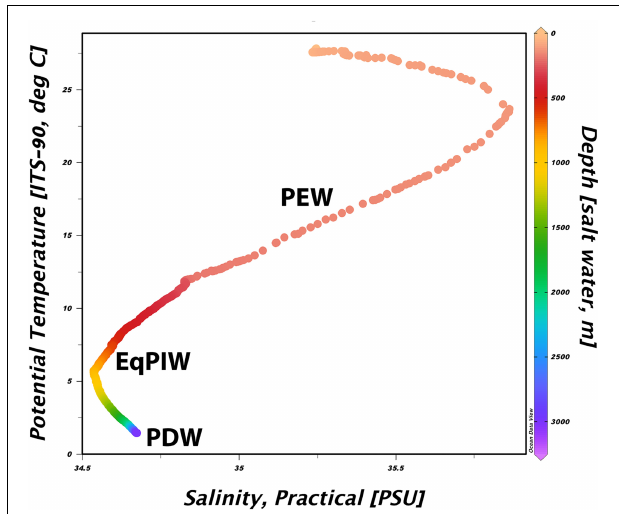
FIGURE 3 | Temperature-salinity diagram from the sea surface to 3000 m collected via CTD rosette downcast North of Kanton Atoll. The approximate depth of each water mass identified below 200 m is overlaid in bold. Plot was constructed using Ocean Data View v5.1 (Schlitzer, 2019).